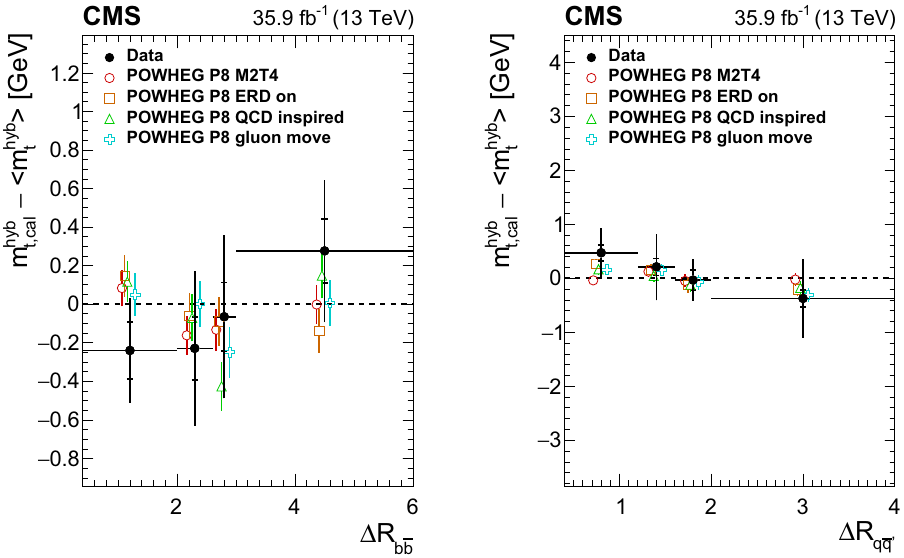
Fig. 4 Measurements of m t as a function of the Δ R between the b jets Δ R (left) and the bb light-quark jets Δ R qq (cid:4) (right) compared to alternative models of color reconnection. The symbols and conventions are the same as in Fig.